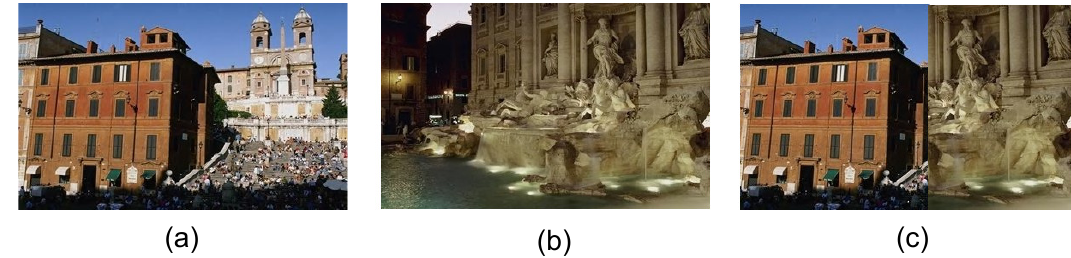
Figure 1. Virtual image generation through genetic algorithm (GA). ( a ) and ( b ) are original images; ( c ) is the virtual image generated by combining image